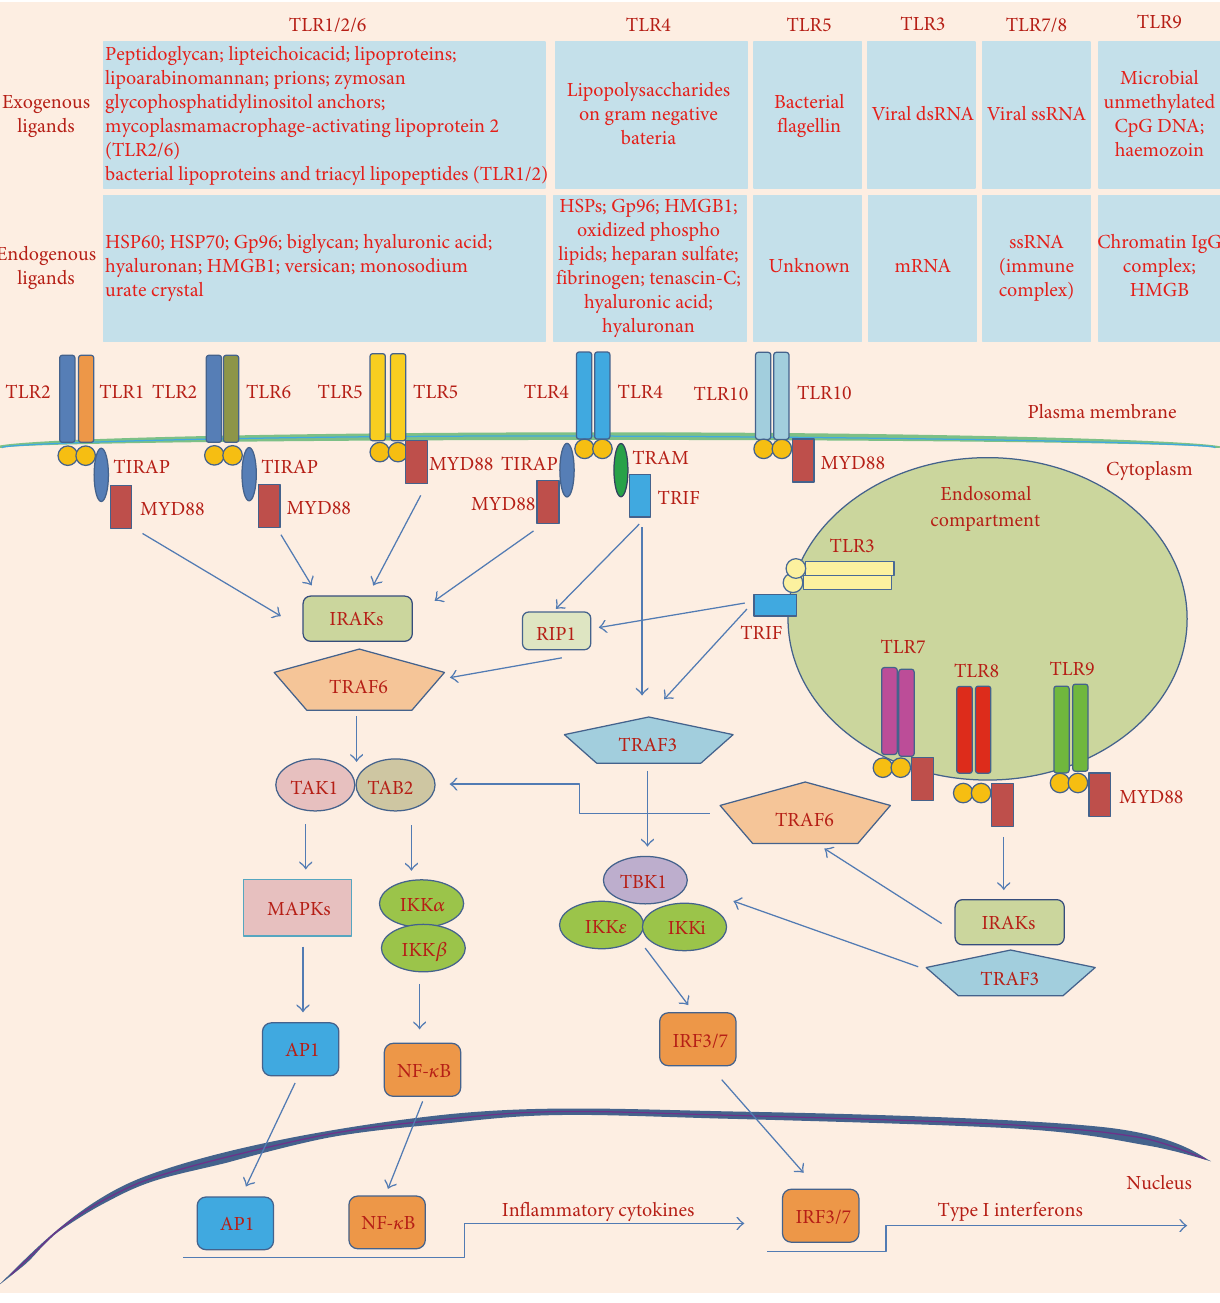
Figure 1: TLR ligands and signaling pathways. TLRs localize to the cell surface and to intracellular vesicles such as endosomes where they respond to their exogenous and endogenous ligands as shown. The TLRs utilize adaptor proteins of the MyD88 family, including MyD88, TRIF, TIRAP, and TRAM, to initiate downstream signaling pathways that induce the activation of various transcription factors, including NF- κ B, AP-1, and IRF3/7, and the production of in fl ammatory cytokines and type I